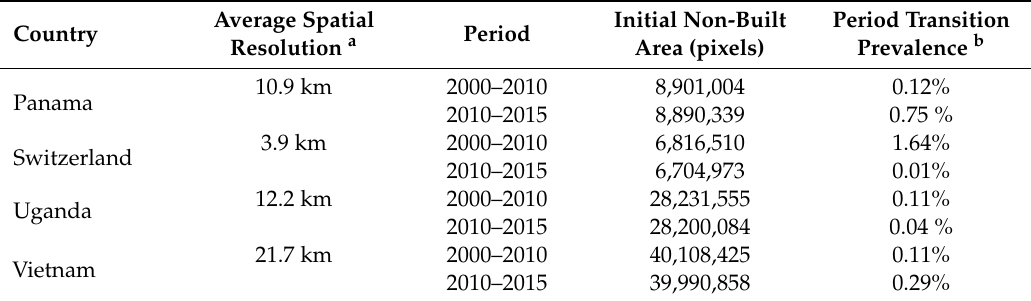
Table 1. Summary of built-settlement transition data by country and period. Areal units here are pixels (~ 100m) as that is the unit handled by the model, which looks at relative areal changes as opposed to absolute areal changes. Adapted from Nieves et al.